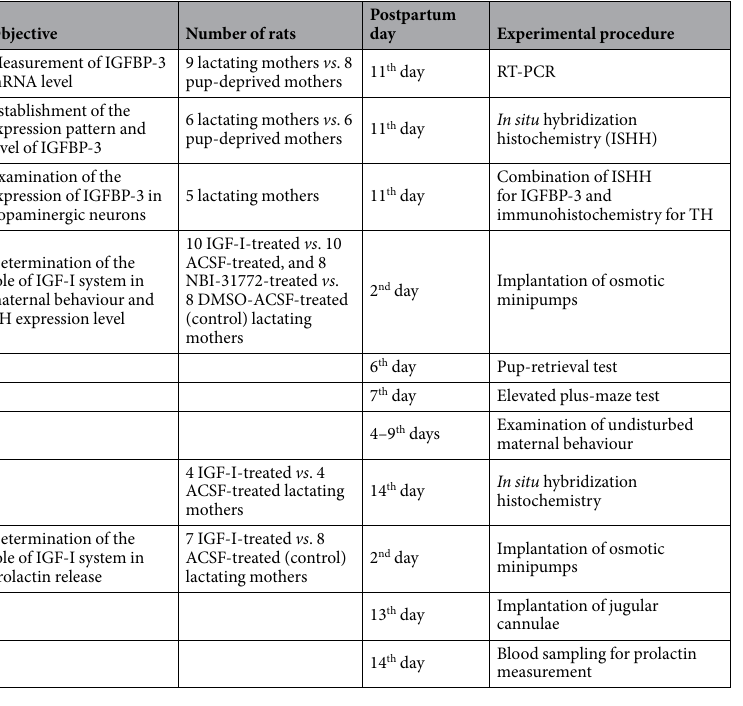
Table 3. Summary and timing of the experiments with specification of the number of used animals in each